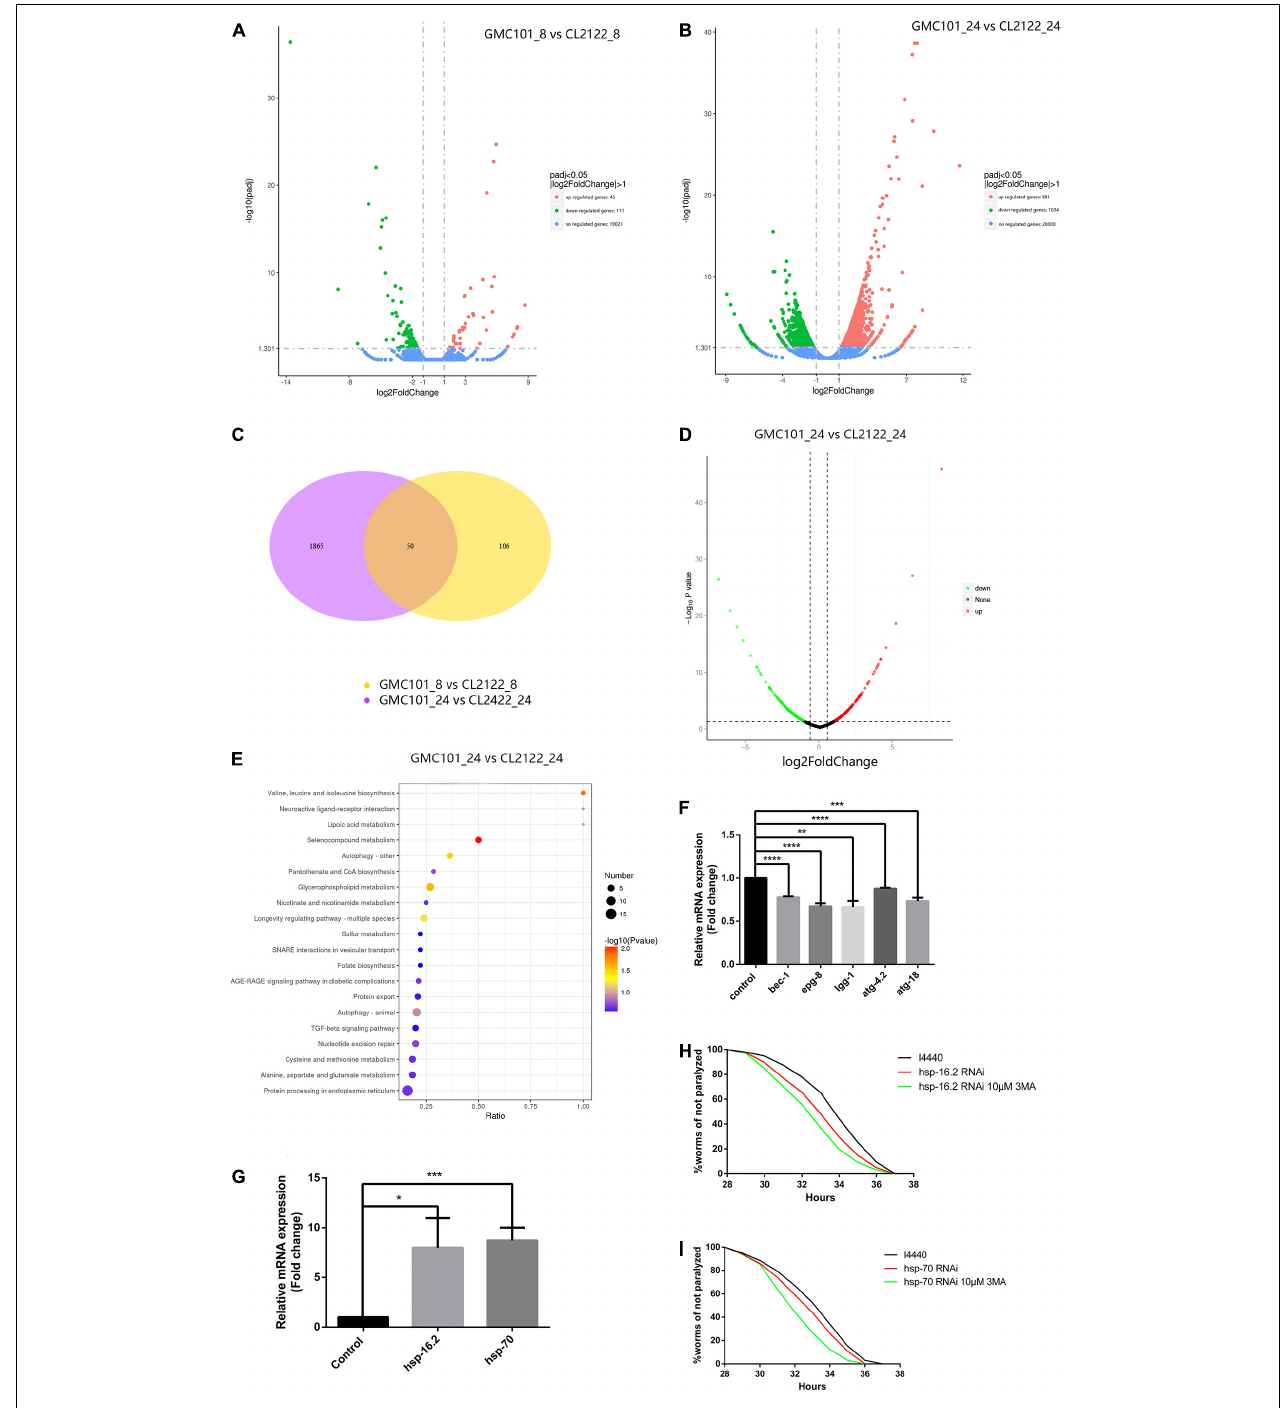
FIGURE 5 | Molecular chaperones are essential for A β toxicity in transgenic nematodes. (A) After 8 h A β induction, 45 genes were up-regulated and 111 down-regulated in GMC101 compared with CL2122 strains. (B) After 24 h A β induction, 881 genes were up-regulated and 1034 down-regulated in GMC101 compared with CL2122 strains. (C) Venn diagram showing the overlap among genes showing significant differential expression ( p < 0.05) between samples. (D) After 24 h A β induction, 273 proteins were up-regulated and 301 down-regulated in GMC101 compared with CL2122 strains. (E) KEGG pathway enrichment of differentially expressed proteins between CL2122 and GMC101 strains. x and y axes represent GeneRatio and enriched KEGG pathway, respectively. Color represents enrichment significance, and bubble size represents gene count. (F) Validation of differentially expressed genes screened by RNA-seq ( n = 3, ** p < 0.01; *** p < 0.001; **** p < 0.0001 by the Student’s t -test). (G) Validation of differentially expressed genes screened by RNA-seq. The CL4176 strain was fed either vector l4440 control bacteria or bacteria expressing RNAi for hsp-16.2 (H) and hsp-70 (I) . RNAi for molecular chaperones accelerated A β -induced paralysis in the CL4176 strain ( n = 3, * p < 0.05 by the log-rank